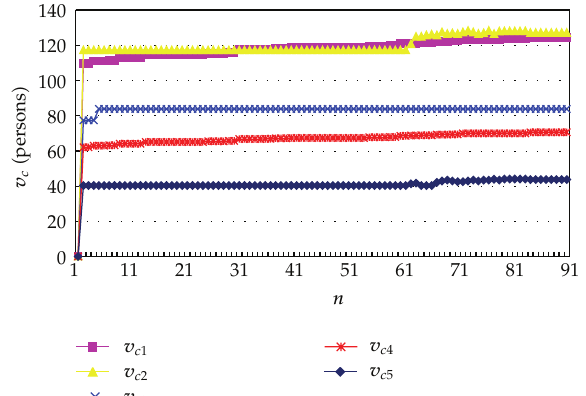
Figure 4: Assigned flows the five connections for θ (cid:9) 1 . 0.